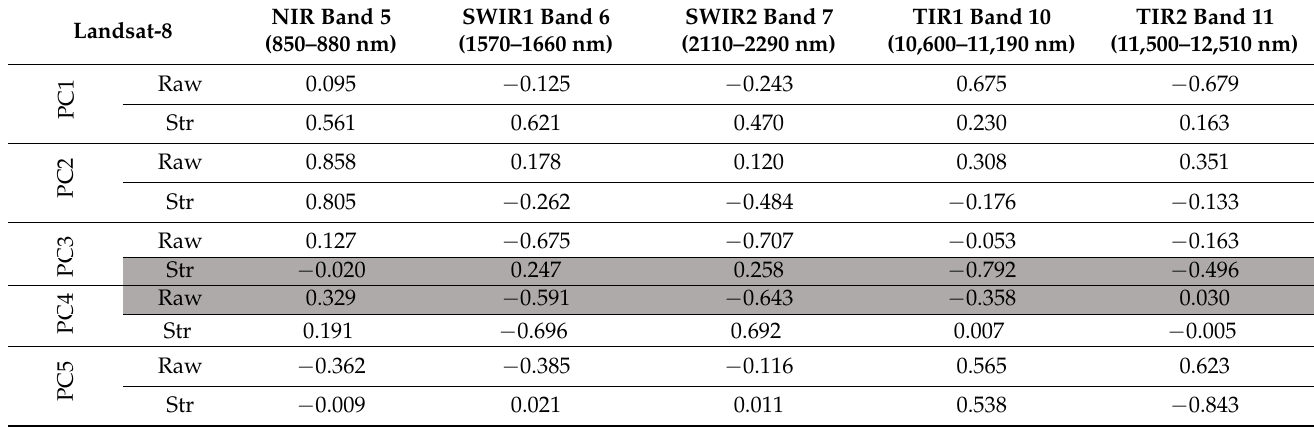
Figure 6. USGS spectral library plots of different granite minerals found in the case studies. Several PCs that mostly retained topographical or vegetation responses and no dis- criminative spectral response of granite and marble were ignored. Key FPCS components were selected from Tables 2–4 based on the absolute loadings of critical bands responding to different associated minerals. Table 2. Eigenvector loadings after applying feature-oriented principal component selection (FPCS) to raw (Raw) and stretched (Str) Landsat-8 Operational Land Imager (OLI) and Landsat-8 Thermal Infrared Band Sensor (TIRS) data. The highlighted components were used in generating the final image shown in Figure